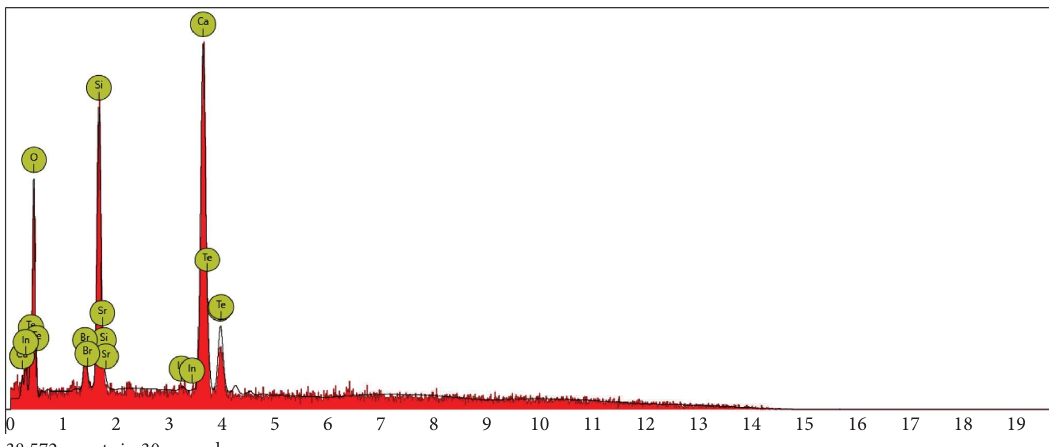
Figure 22: Graphical representation of elements concentration for the control